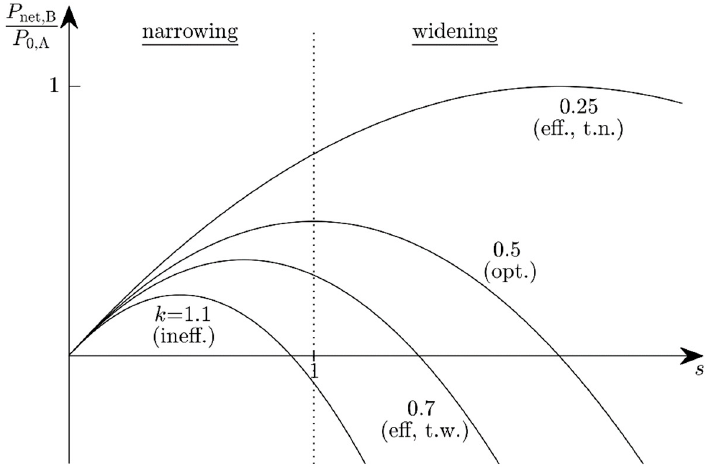
Figure 7. P net,B after ABS with a factor of s with the power ratio k (=adjustment power divided by power harvested prior to the ABS) as a parameter.